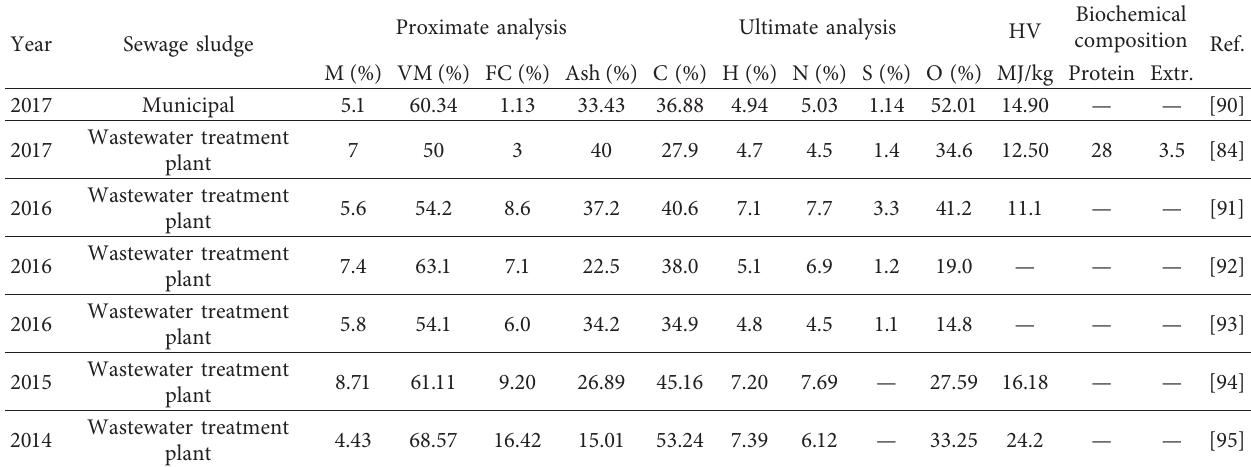
Table 4: Elemental and chemical composition of sewage